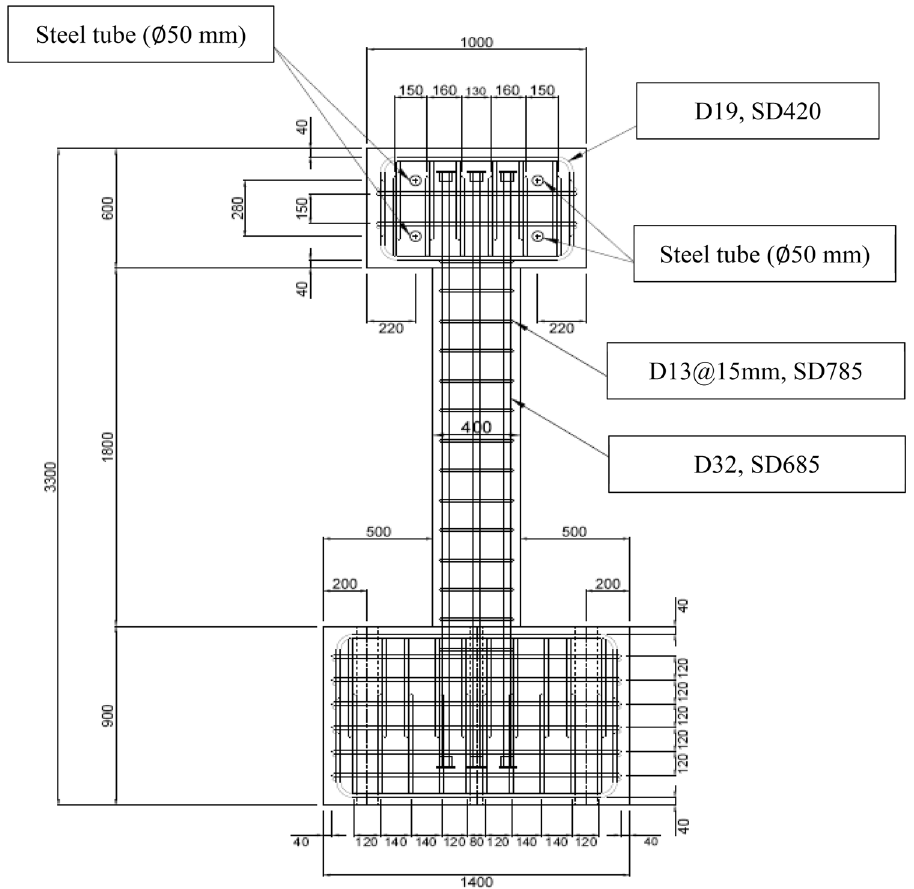
Fig. 7 Cantilever beam specimen of 3C15S (unit: mm).